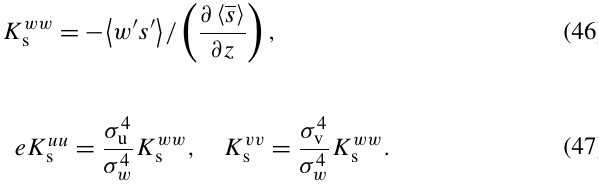
Figure 9. (a) Total momentum fluxes obtained in LES with (cid:49) g = 2.0m. (b) Normalized RMS of vertical velocity e σ w = σ w / | τ | 1 / 2 depending on a dimensionless parameter z/(cid:51) (solid red line - estimation using LES data σ w = ( (Grachev et al., 2013) at different heights). (c) Variances of velocity components (dashed line – resolved fluctuation; solid lines – the final estimation for LSM; bold red lines – vertical component, green curves of medium thickness – crosswind component, blue thin lines – longitudinal component, circles – evaluation of σ 2 w by Eq. 41). (d) Vertical effective eddy diffusivity K ww s (red solid line – coefficient calculated by the gradient and flux of scalar; dashed line – estimation of coefficient using Eq. (13) with C 0 = 6); estimations of diffusion coefficients in crosswind direction K vv s (green dash-dot line) and coefficient in longitudinal direction K uu s (blue dash-dot-dot